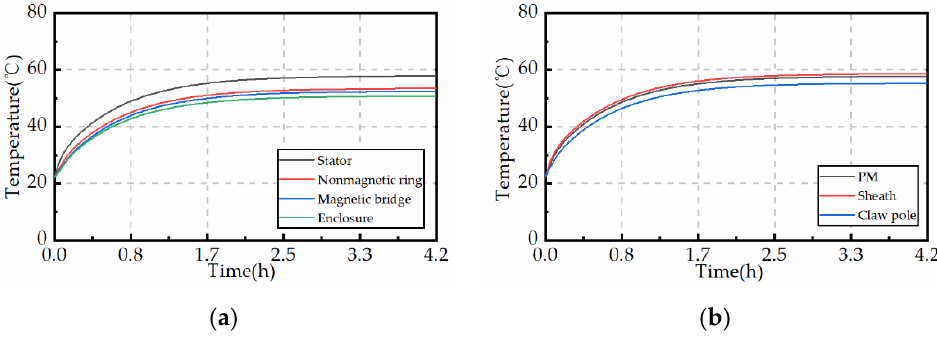
Figure 13. Temperature rise curve of different components in DHEG when the excitation current is 0: ( a ) Stator part; ( b ) Rotor part.